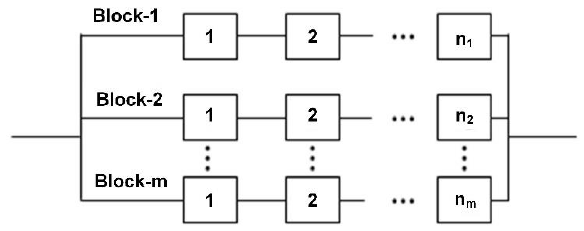
Figure 4. Squib energizing circuit. ( a ) Booster circuit for high current; ( b ) capacitor discharging circuit . Figure 5. Parallel series system structure . Figure 5. Parallel series system